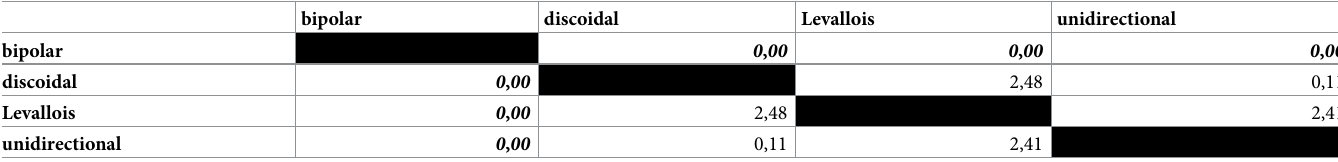
Table 3. Results of the pairwise comparison from the MANOVA test. Knapping method is the independent variable, while size classes are the dependent variables. bipolar discoidal Levallois unidirectional bipolar 0 , 00 0 , 00 0 , 00 discoidal 0 , 00 2,48 0,11 Levallois 0 , 00 2,48 2,41 unidirectional 0 , 00 0,11